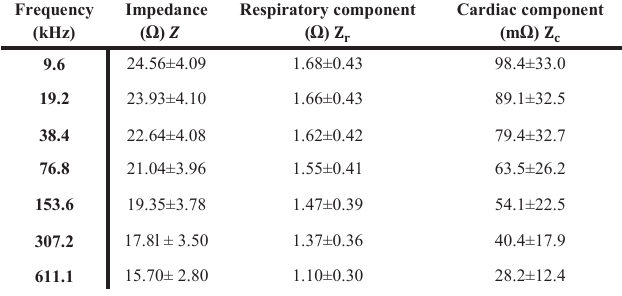
Table 1: Thoracic impedance; mean data with the standard deviation for the 12